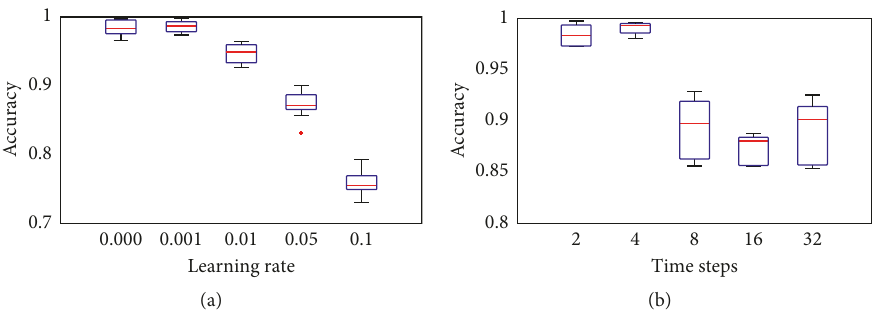
Figure 7: Diagnostic accuracy at different optional values. (a) Learning rate. (b) Time steps. Table 2: Statistical features. Domain